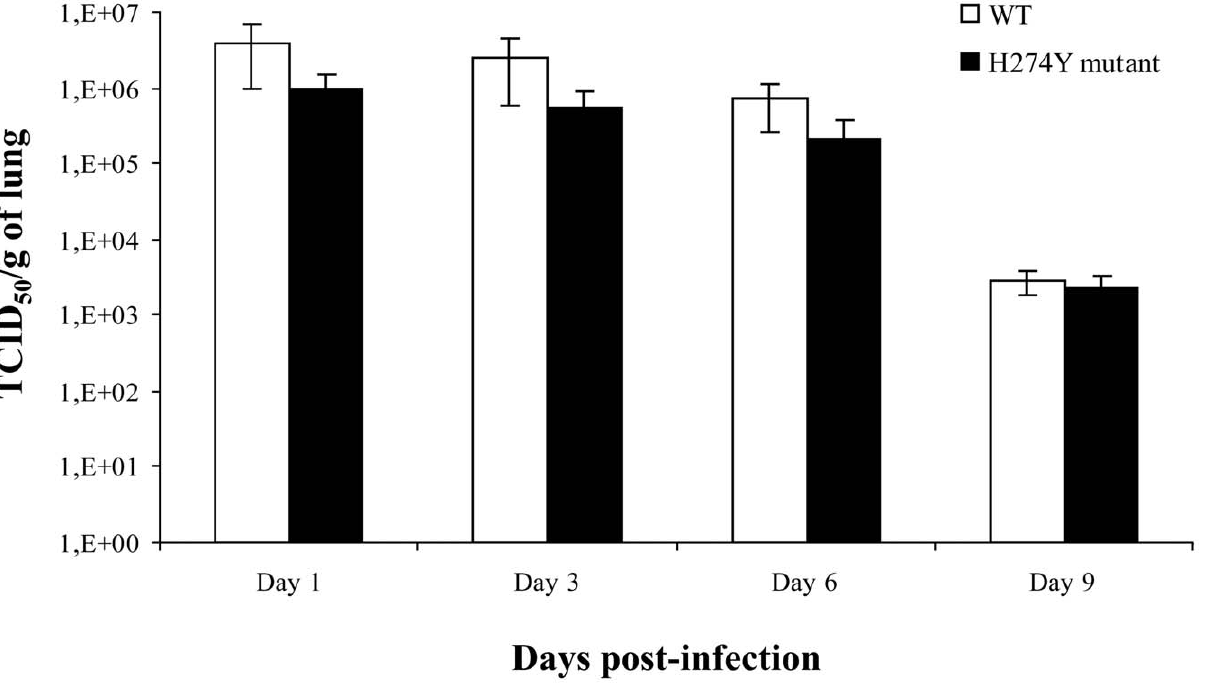
Figure 3. Lung viral titers of mice infected with wild-type (WT) or H274Y mutant isolates of pH1N1. Mice were infected intranasally with 5 6 10 5 PFUs of either WT pH1N1 (A/Que´bec/147023/2009) or oseltamivir-resistant H274Y mutant (A/Que´bec/147365/2009) isolate. Three to four mice per group were sacrificed on days 1, 3, 6 and 9 for determination of lung viral titers, which were reported as TCID 50 per gram of lung.